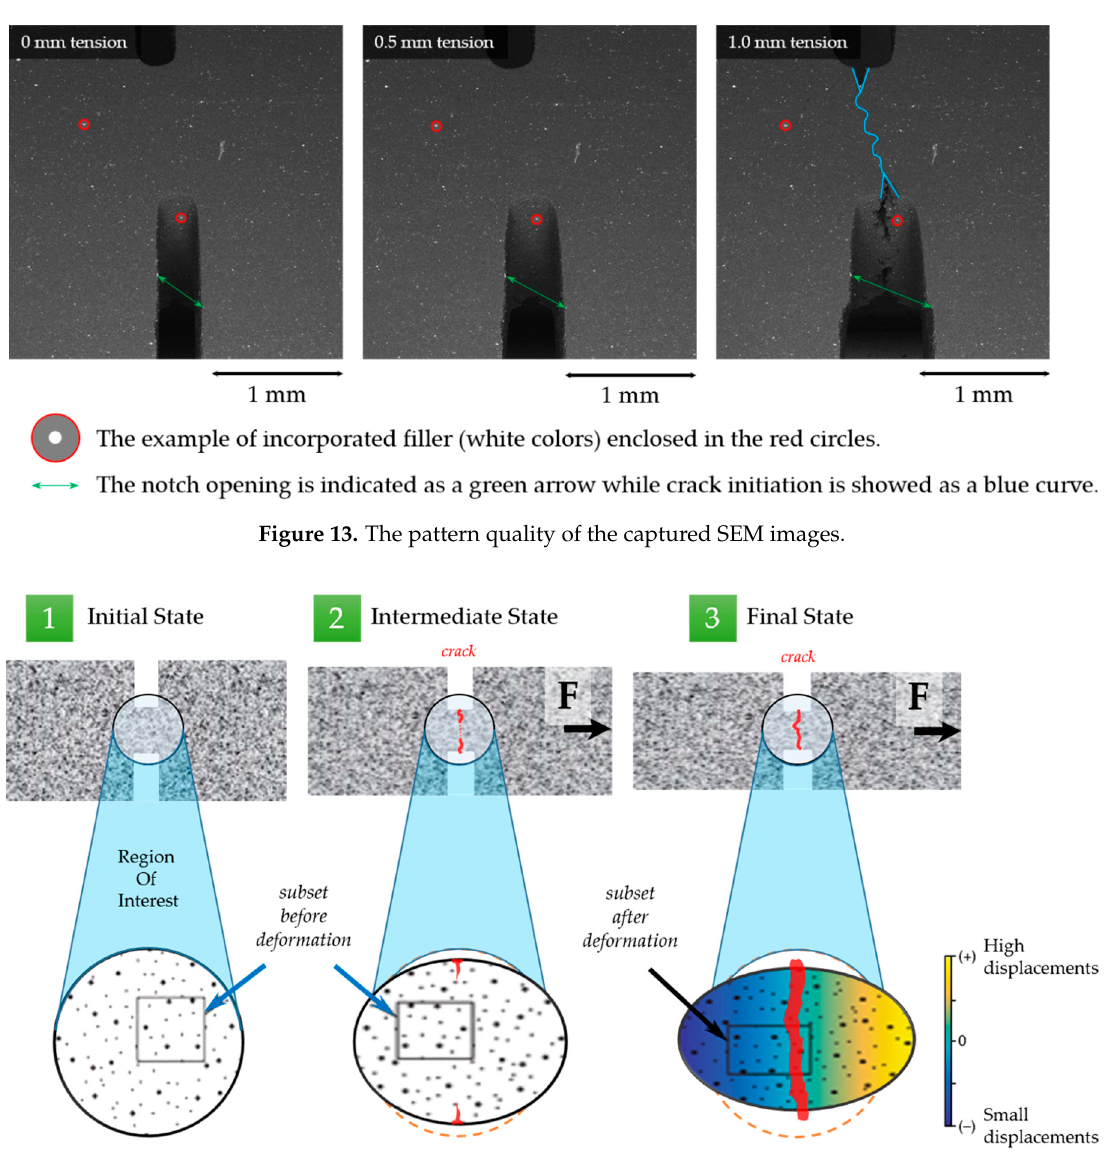
Figure 14. The workflow of the digital image correlation (DIC) analysis.